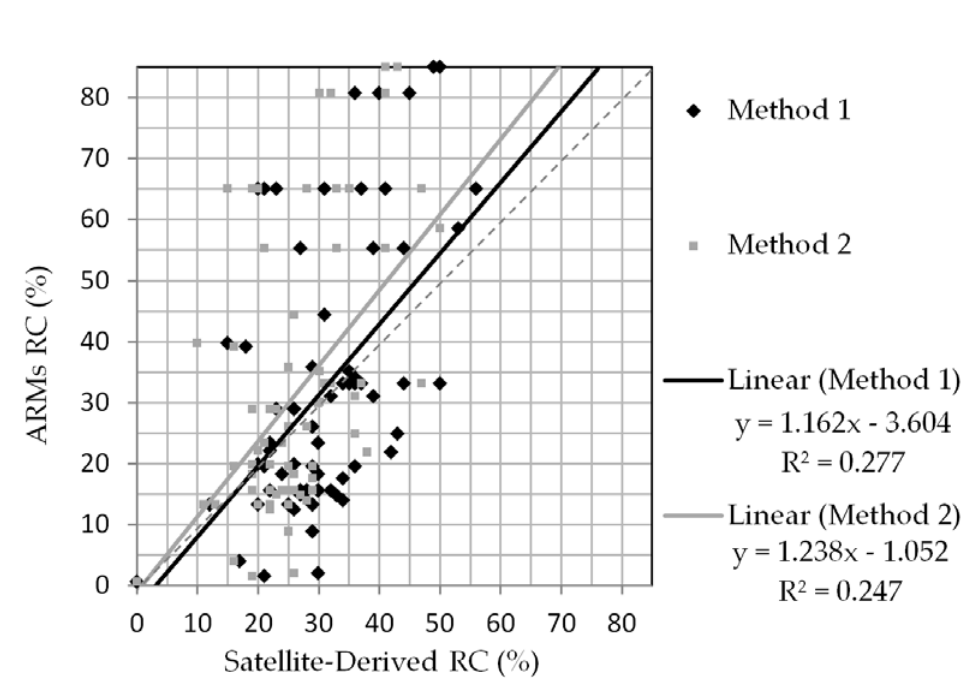
Figure 7. ( A ). For Method 2 adjusting the ARMS data near the category boundary by ± 5% did not affect R 2 (gray dotted and blue dashed lines overlaying each other). ( B ). Using points four or more satellite overpasses for Methods 1 and 2 increases R 2 and slope is closer to one-to-one (black line).